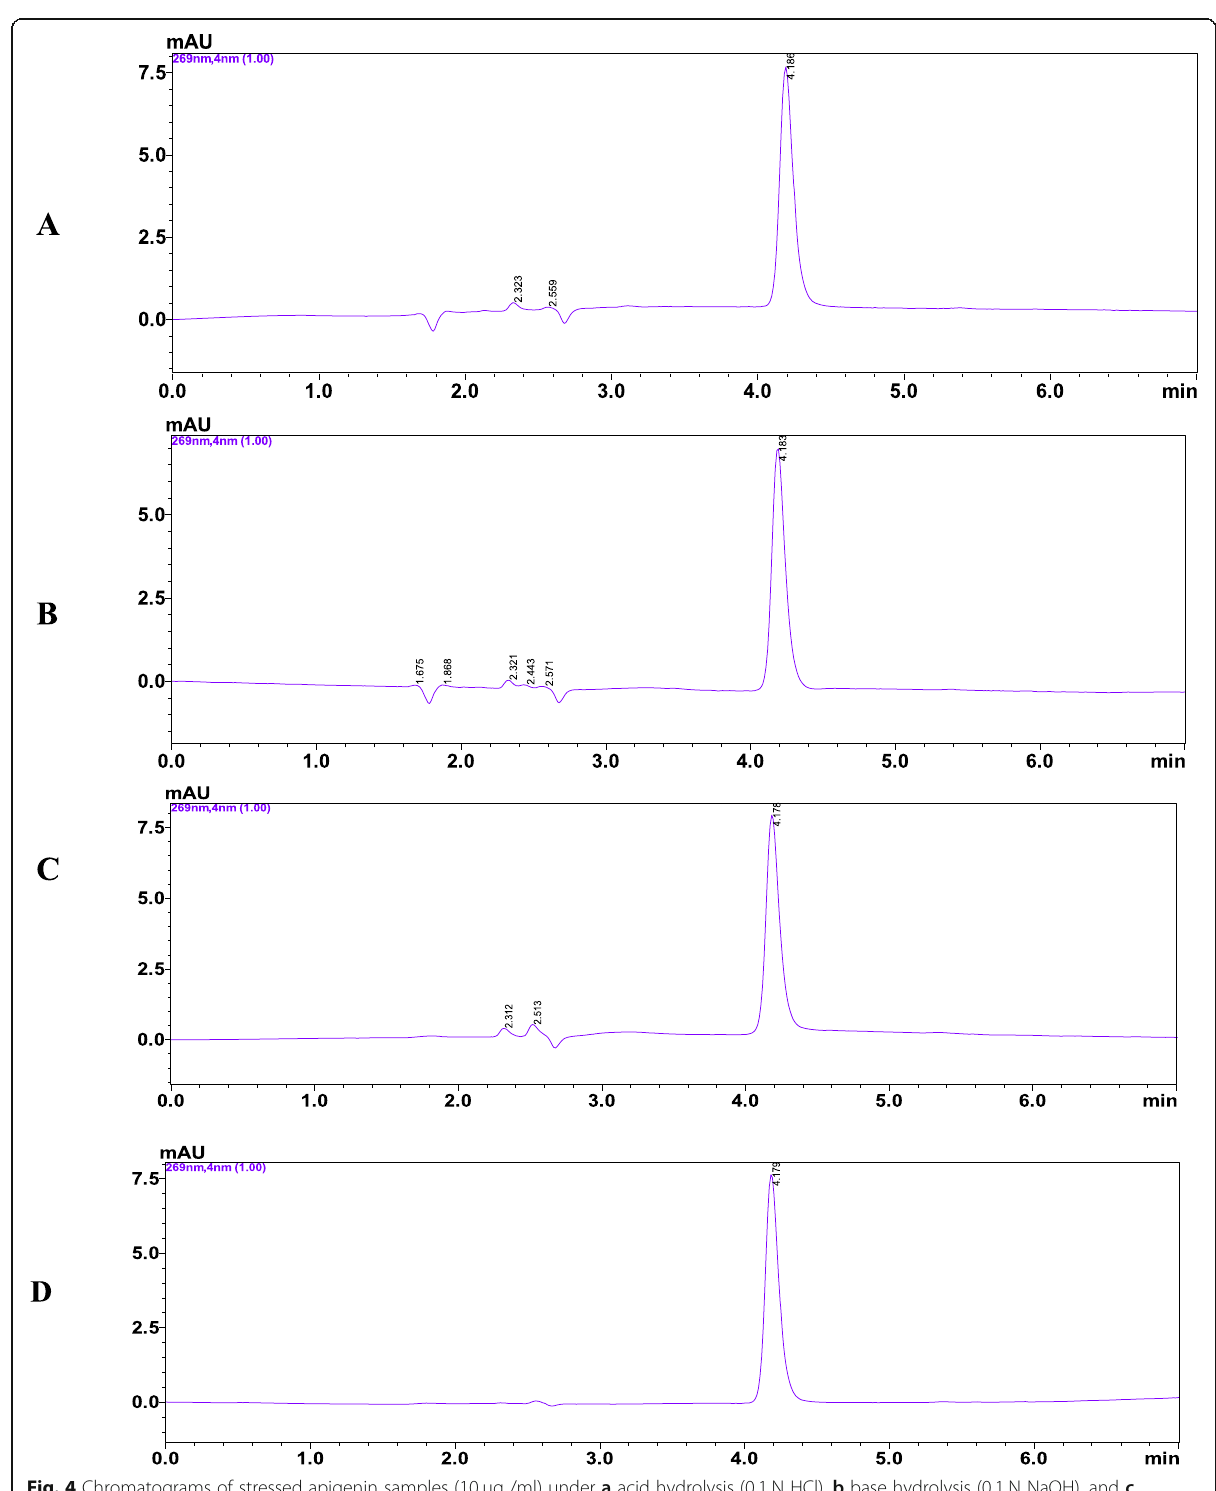
Fig. 4 Chromatograms of stressed apigenin samples (10 μ g /ml) under a acid hydrolysis (0.1 N HCl), b base hydrolysis (0.1 N NaOH), and c oxidative degradation (3% H 2 O 2 ), and d heat (80